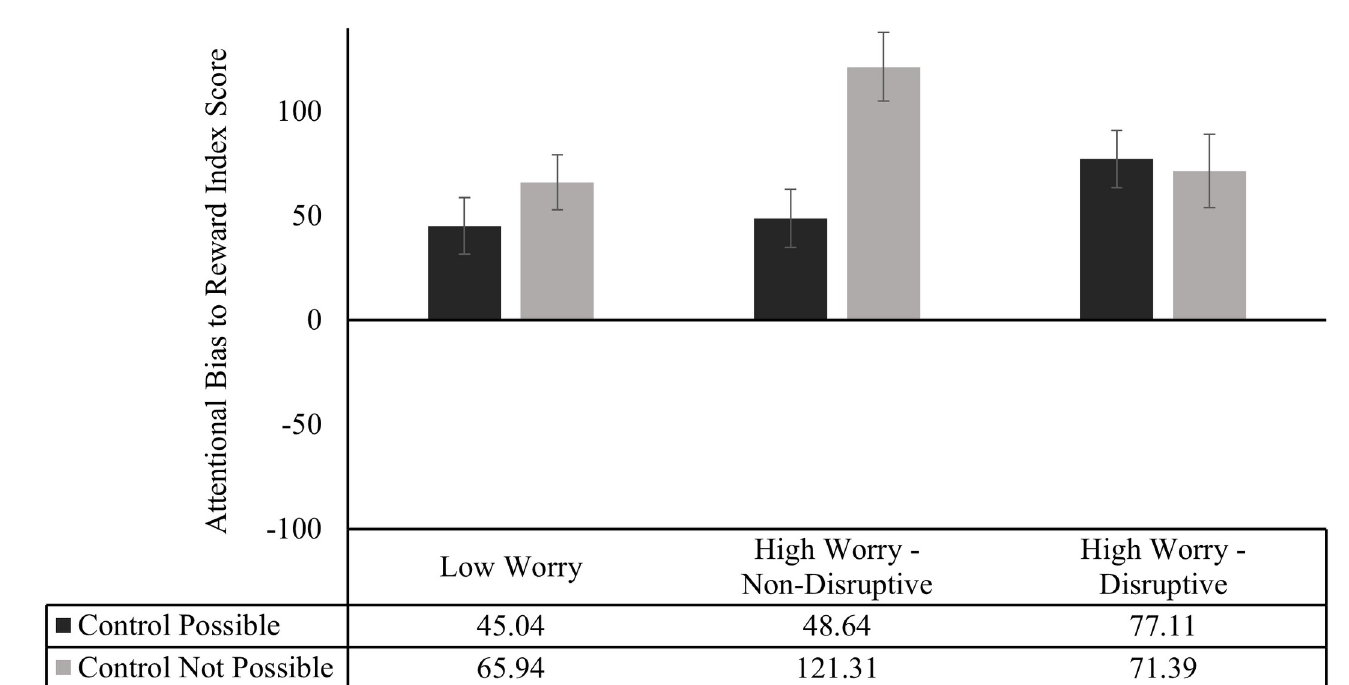
Fig 4. Attentional Bias to Reward Index scores for each group in control possible and control not possible blocks. Errors bars are standard error bars.